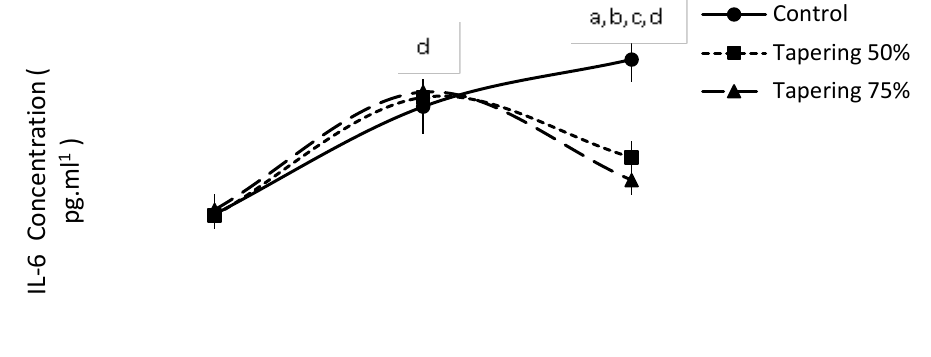
Fig 1: The comparison of the IL-6 plasma levels before, after training phase as well as after tapering period in three groups. Significant differences between tapering 50% and control group are indicated with (a) where P<0.05; Significant differences between tapering 75% and control group are indicated with (b) where P<0.05, Significant differences between tapering 50% and tapering 75% group are indicated with (c) where P<0.05, Significant differences from baseline are denoted by (d) where P<0.05. Values are mean ±